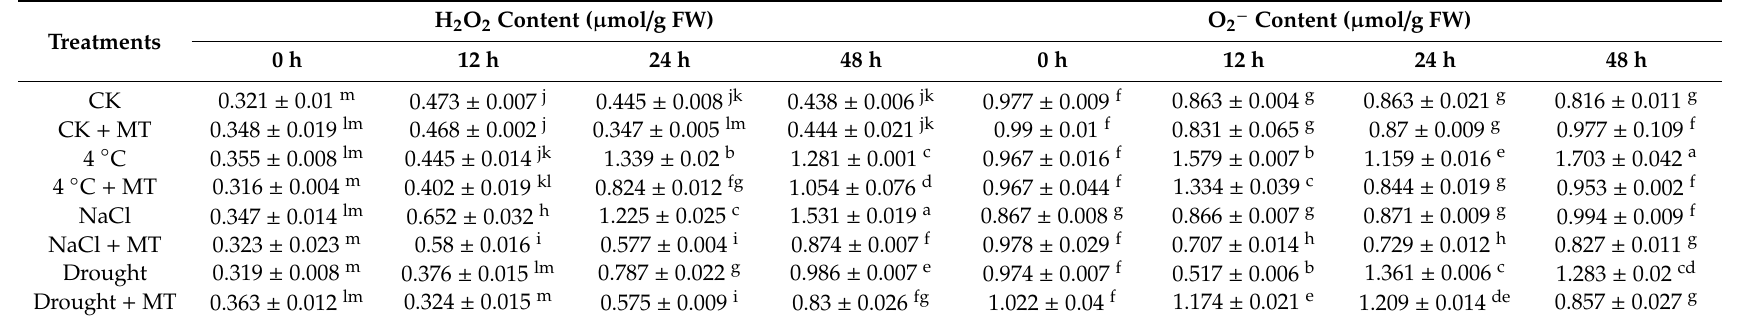
Table 1. E ff ect of exogenous melatonin on H 2 O 2 and O 2 − levels in tea leaves on the designated